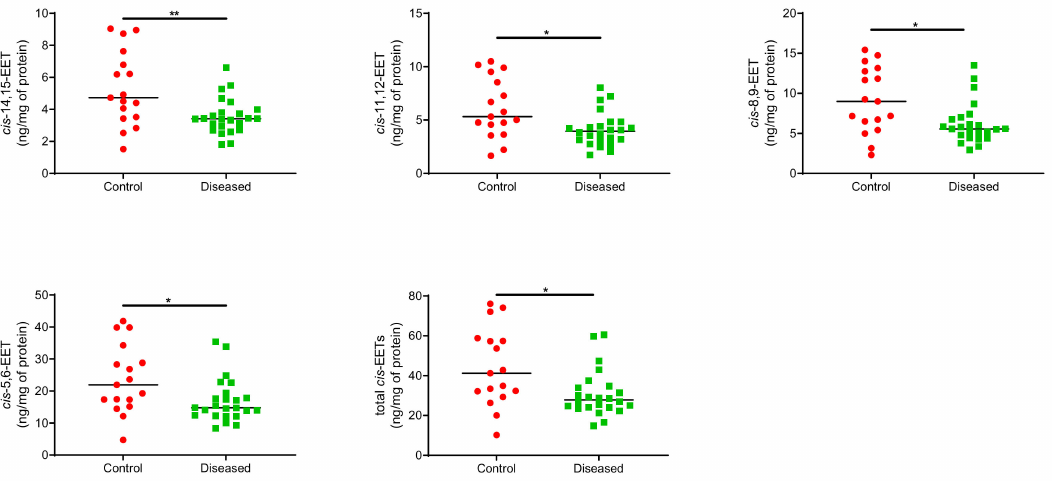
Figure 2. Individual cis -EET and total cis -EETs extracted from control ( n = 17) and diseased ( n = 24) human cardiac tissues. ** indicates p ≤ 0.01 and * indicates p ≤ 0.05.